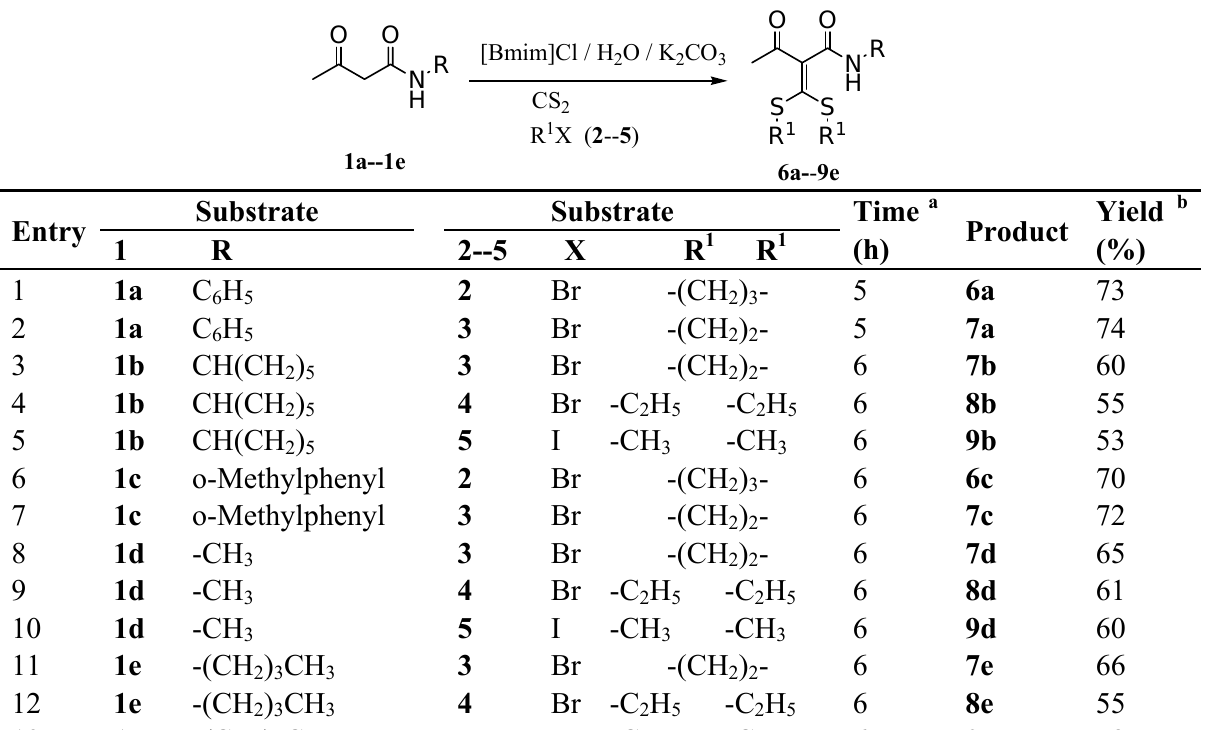
Table 3. Preparation of α -oxoketene S,S-acetals 6a-9e from 1,3-dicarbonyl compounds 1 in [Bmim]Cl/H 2